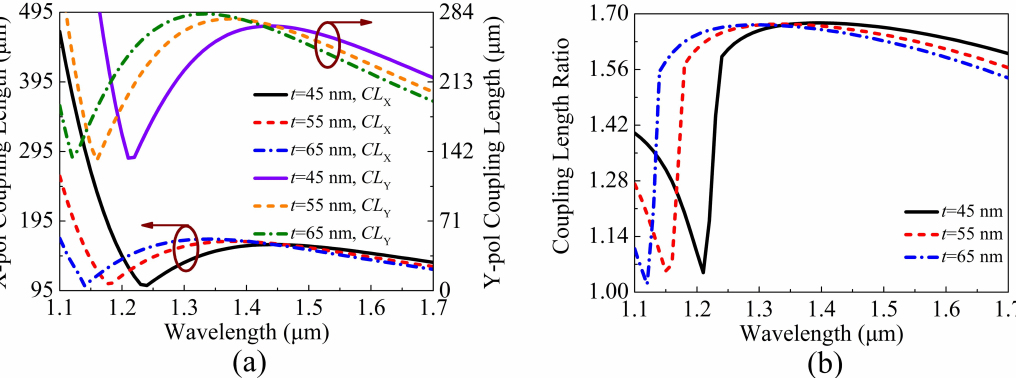
Figure 9. The variations of the ( a ) CL X , CL Y , and ( b ) CLR of the proposed V-DC-PCF PBS for different t